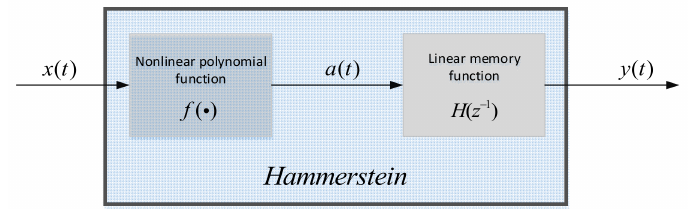
Figure 2. Hammerstein